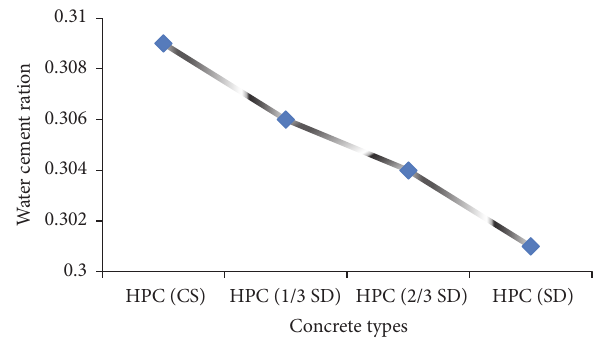
Table 5: Nomenclature of formulated HPC. Concrete Denomination